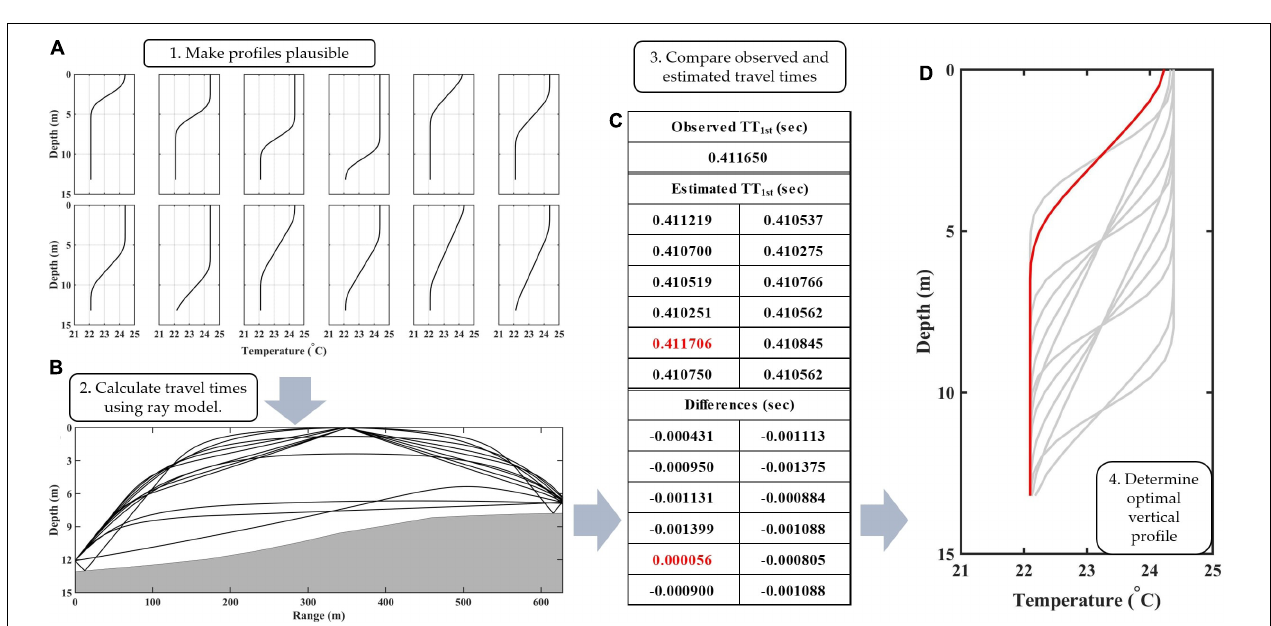
FIGURE 2 | (A) Temperature profiles created using water depth, SST, and NBT. (B) Eigenrays of the ATT 1st in each of the temperature profiles. (C) Example of comparison between observed ATT 1st and calculated ATT 1st . The value of ATT 1st closest to the observed value is displayed in red. (D) The determined optimal profile is plotted as the red line. SST, Sea surface temperature; NBT, Near-bottom temperature; and ATT, Acoustic travel time.